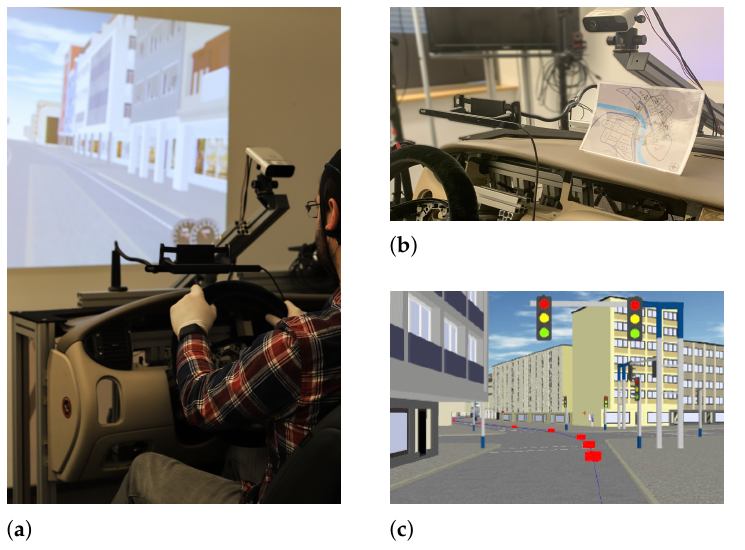
Figure 3. ( a ) Participant driving in a test phase; ( b ) view of the cockpit with a printed map in place; and ( c ) a shot of the simulated screen in the learning phase with the navigation